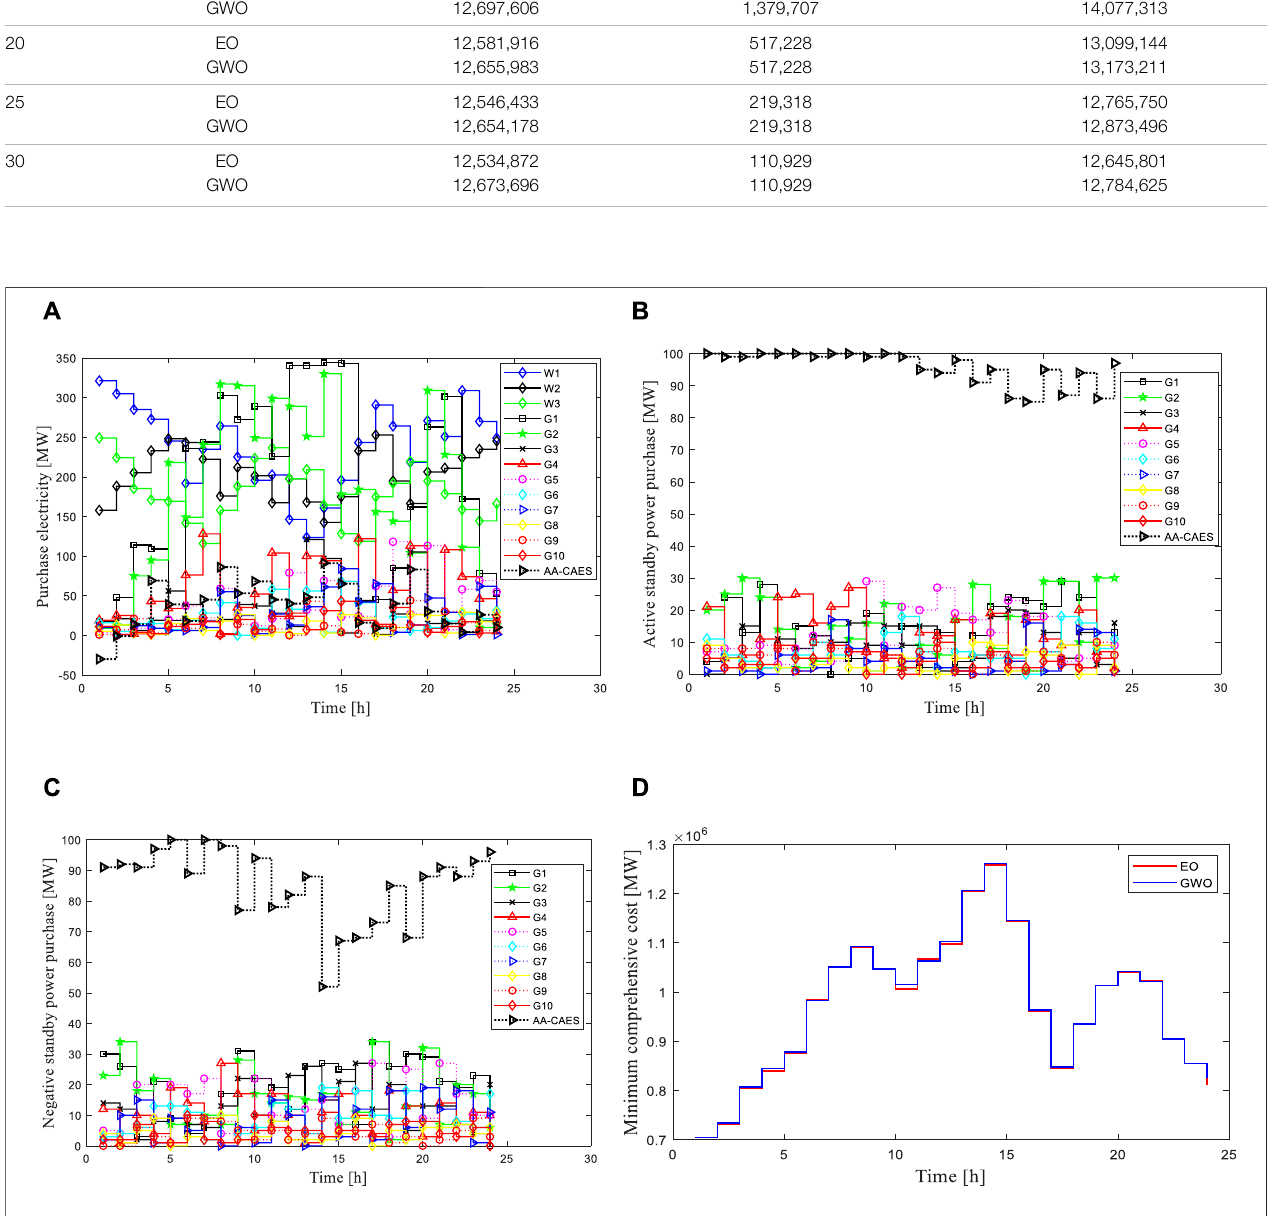
FIGURE 3| Optimal scheduling scheme and corresponding minimum comprehensive cost: (A) Unit output; (B) Unit active standby; (C) Unit negative standby; (D) Minimum comprehensive cost at all times.